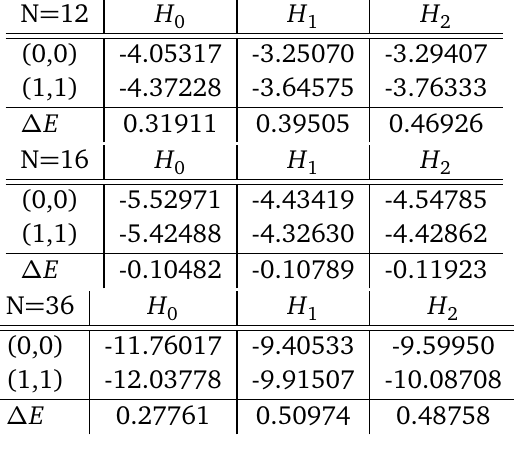
Table 3: Energies of the lowest energy states in the two topological sectors, as well − E as the gap ∆ E = E ( ( 1,1 ) , obtained using ED of the dimer models H n (where 0,0 ) n = 0,1,2 is the order of the expansion in the parameter x = 1 / 6) for three different system sizes. N = 12 H 0